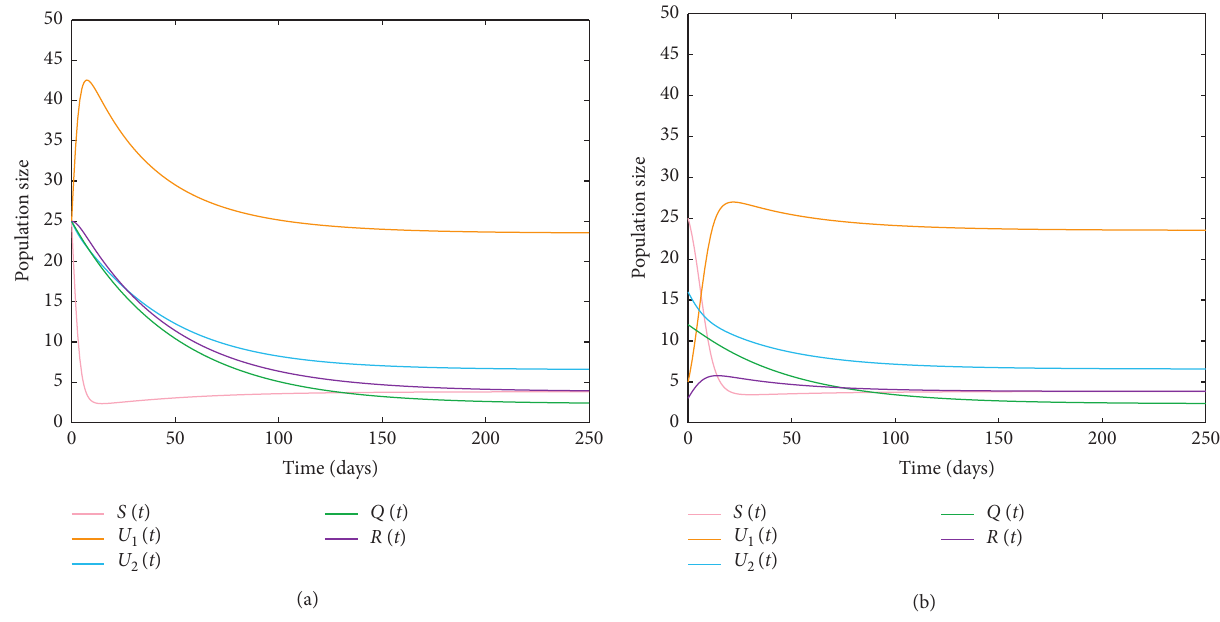
Figure 4: The stability of E ∗ with different initial values. (a) The stability of E ∗ with an initial value I